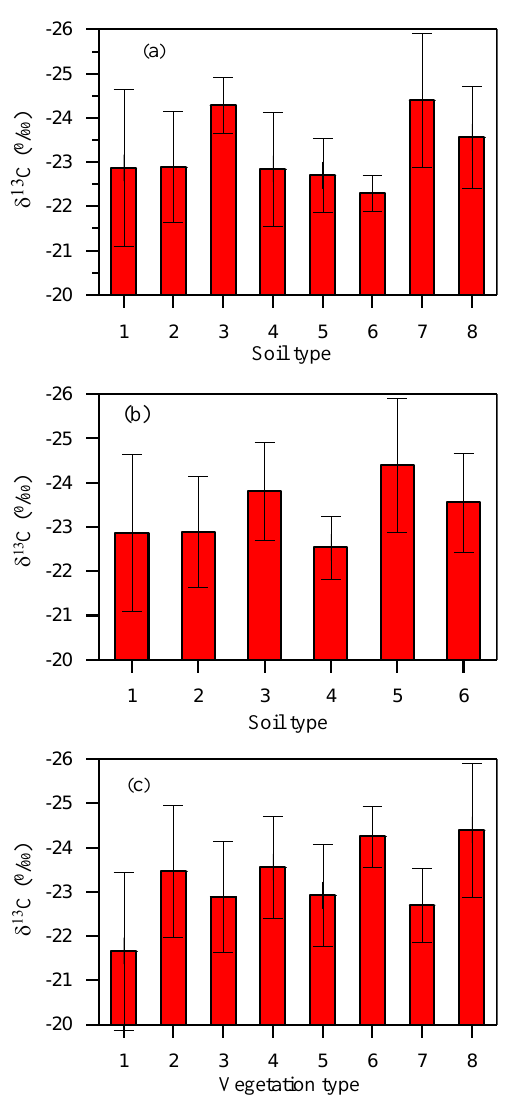
Figure 5. Shows the effects of soil types and vegetation types on the soil δ 13 C. (a) Soil types based on Chinese soil taxonomy. 1. Mat- tic Gelic Cambosols; 2. Haplic Cryic Aridosols; 3. Calcic Orthic Aridosols; 4. Mottlic Calcic Orthic Aridosols; 5. Typic Calcic Us- tic Isohumosols; 6. Pachic Ustic Isohumosols; 7. Umbric Gelic Cambosols; 8. Haplic Ustic Argosols. (b) Soil types based on the WRB. 1. Cambisols; 2. Leptosols; 3. Calcisols; 4. Chernozems; 5. Umbrisols; 6. Luvisols. (c) Vegetation type. 1. Alpine grassland; 2. alpine meadow; 3. subalpine grassland; 4. temperate conifer- ous and broad-leaved mixed forests; 5. temperate meadow steppe; 6. semi-desert grasslands; 7. temperate typical steppe; 8. frigid tem- perate coniferous forest. The bar in Fig. 5 indicates ±